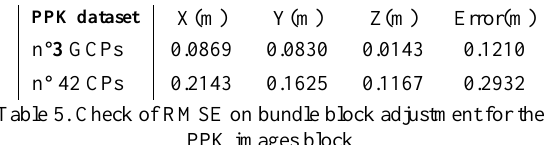
Table 5. Check of RMSE on bundle block adjustment for the PPK images block